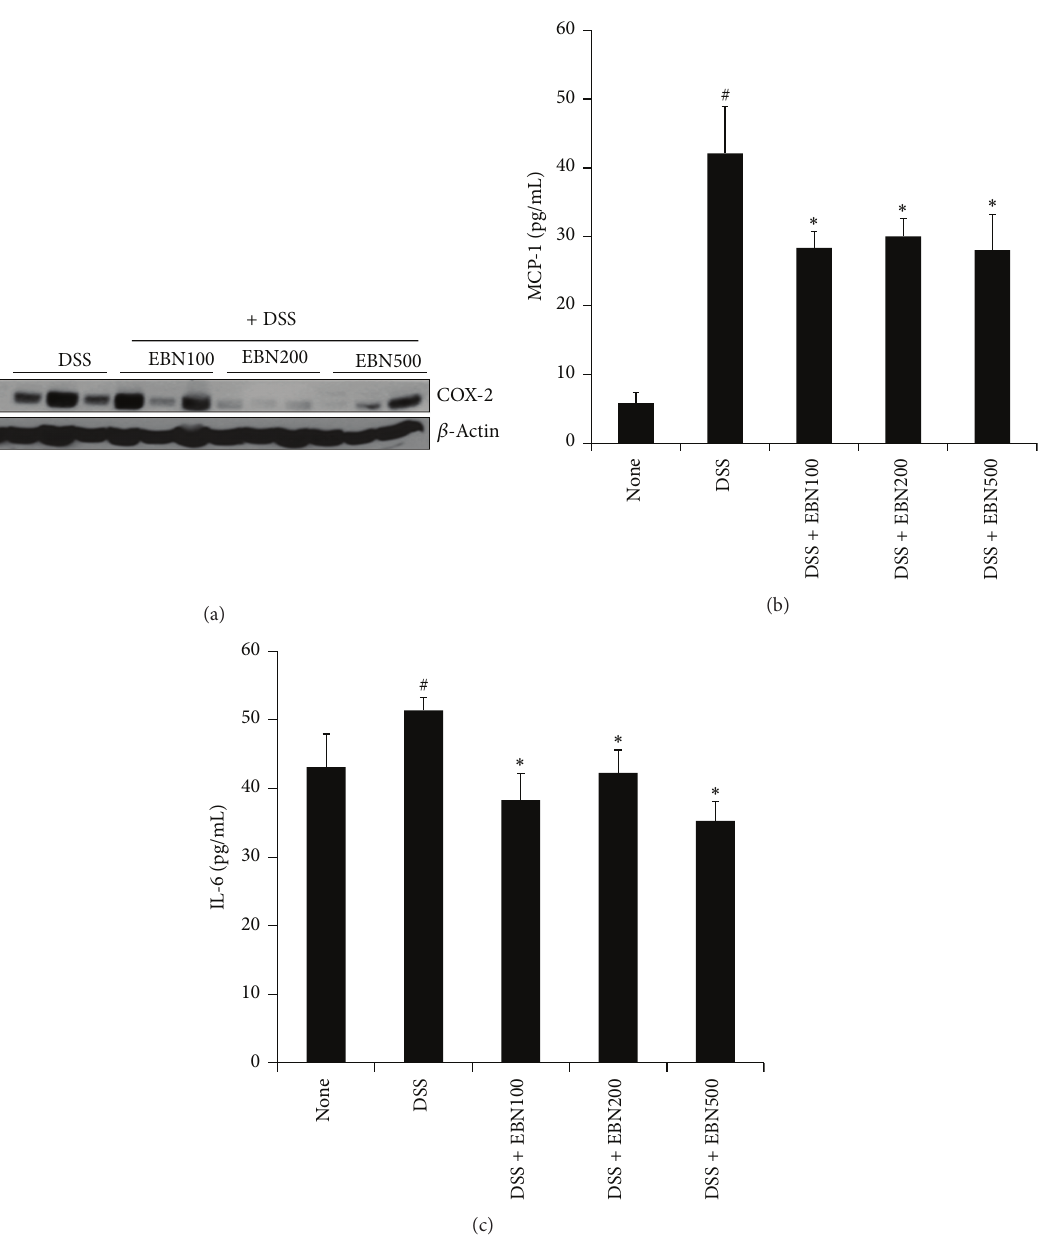
Figure3:TheeffectofEBNonIL-6,MCP-1,andCOX-2levelsinDSS-inducedcolitismice.COX-2levelsweremeasuredincolontissuelysates by using western blot analysis (a). 𝛽 -Actin was used as an internal control. Serum levels of IL-6 and MCP-1 were measured using enzyme- linked immunosorbent assays (ELISAs) ((b) and (c)). The levels of IL-6, MCP-1, and COX-2 are shown for the untreated, DSS-treated, DSS + EBN 100, DSS + EBN 200, and DSS + EBN 500 groups. All data are expressed as the mean ± SD. ∗ 𝑃 < 0.05 versus DSS-treated; # 𝑃 < 0.05 versus